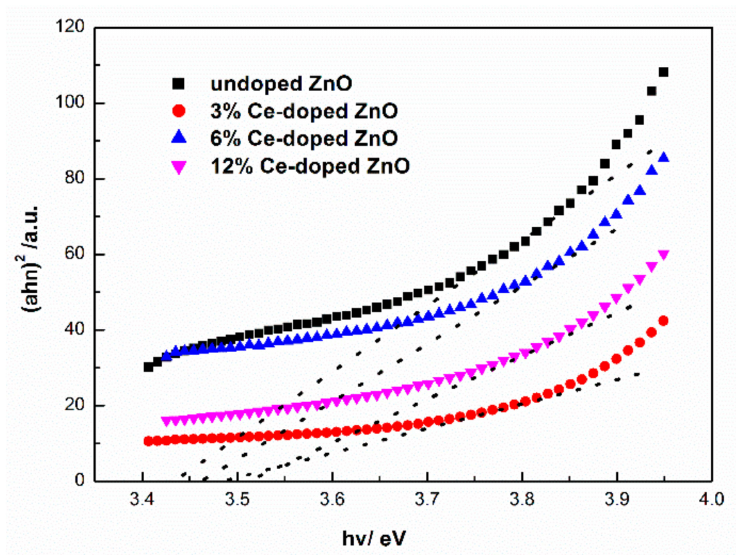
Figure 6. Optical band gap (a is intercepted between 314–376 nm) of un- and different Ce-doped ZnO films. The PL emission spectra of un-and different Ce-doped ZnO film under 375 nm exci- tation are shown in Figure 7. All films have emission peaks at about 424 and 442 nm. An emission of 424 nm is assigned to the recombination of the Zn interstitial levels to the top of the valence band; 442 nm emission is attributed to the recombination of O vacancies to the valence band [32]. CIE-1931 chromaticity coordinates of samples is (0.1518, 0.0594), (0.1517, 0.0602), (0.1518, 0.0603), (0.1519, 0.0598) for undoped and 3%, 6%, 12% Ce-doped ZnO, respectively (Figure 8). The color purity was calculated using [40]